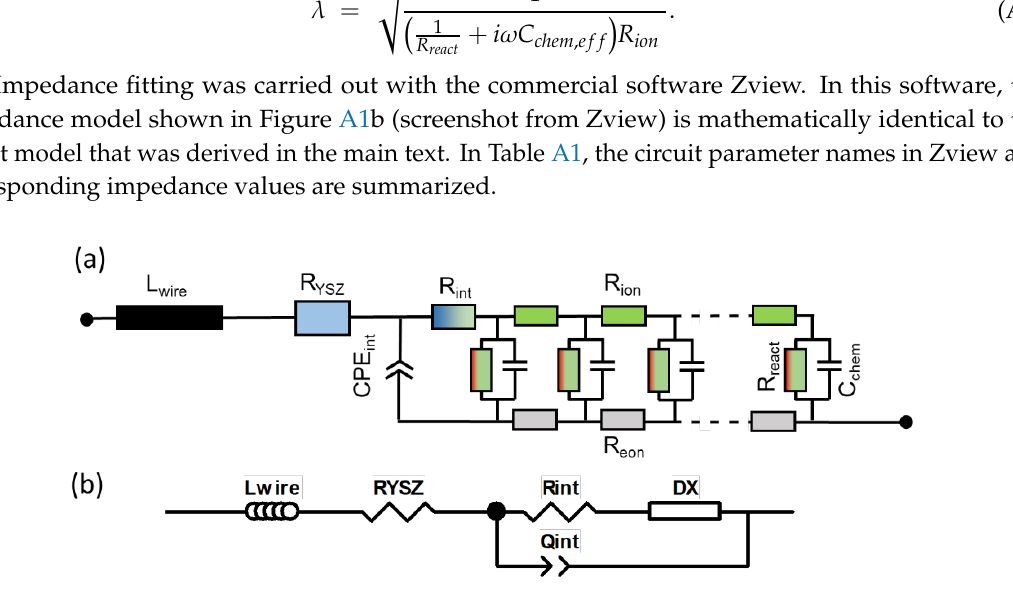
Figure A1. ( a ) Equivalent circuit representing conduction and reaction laws of a mixed conductor. ( b ) Mathematically identical circuit model employed in Zview. Table A1. Relation of Zview fitting parameters to the impedance function in Equation S1.